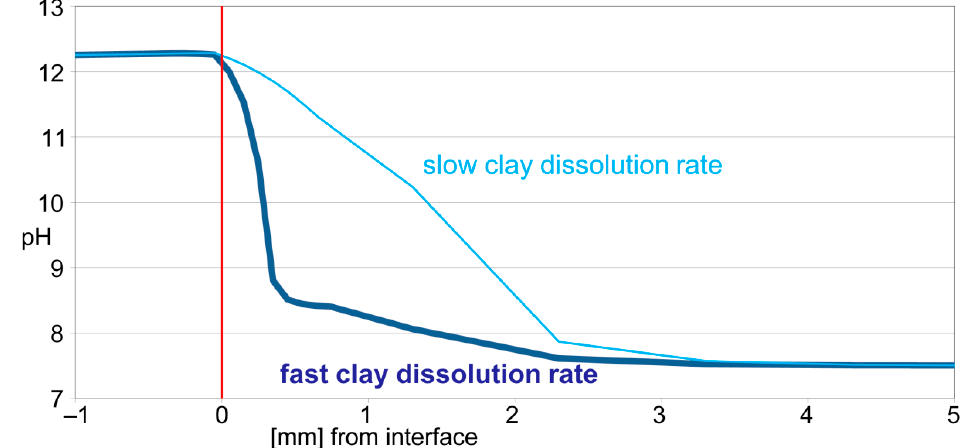
Figure 3. pH profiles across the OPA free porewater after 10 h of interaction with ESDRED, modelled with slow and increased reaction rates of illite and kaolinite. Interface at 0 mm, ESDRED on the left, OPA on the right.